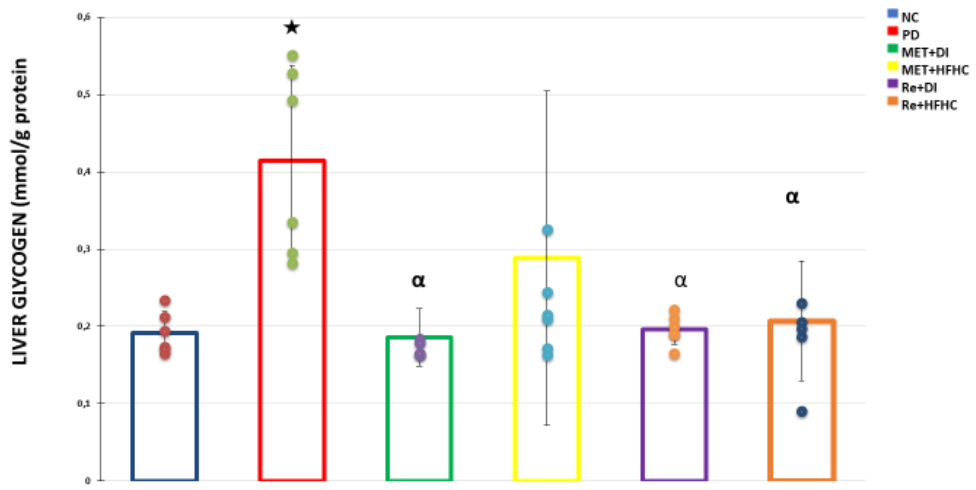
Figure 3. Liver glycogen concentration in NC, PD, MET + DI, MET + HFHC, Re + DI and Re + HFHC after 12 weeks of treatment. Values are presented as means ± SD and individual data points ( n = 6). * p < 0.05 by comparison with NC, α p < 0.05 by comparison with PD, MET + DI, MET + HFHC, Re + DI and Re + HFHC.